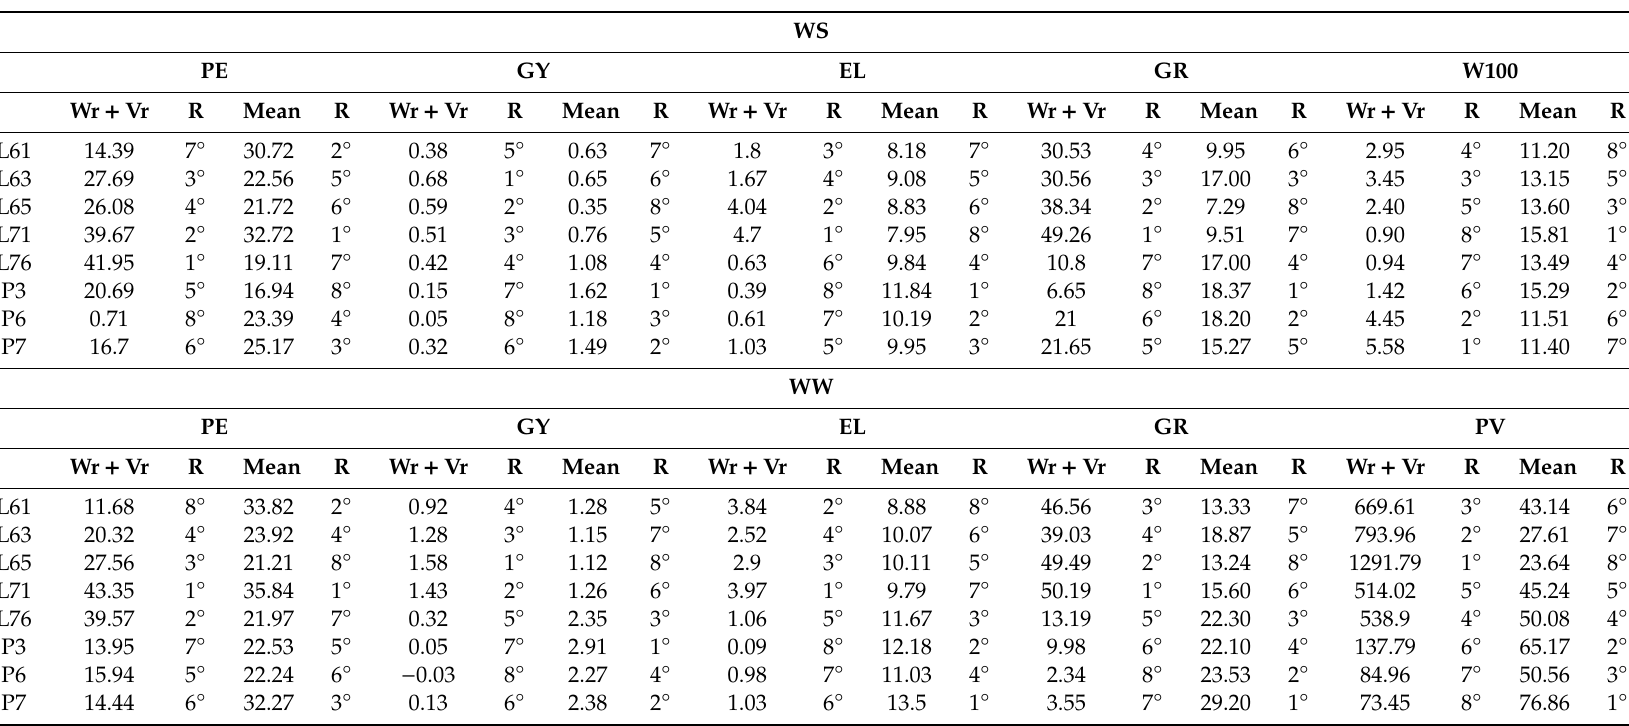
Table 6. Sum of covariance values between parent means and means of crosses with the parent ( ˆ W r ), with variance between means of crosses with the parent ( ˆ V r ) and classification of the sum and parent means and their classification of popcorn genotypes under water-stress (WS) and well-watered (WW)